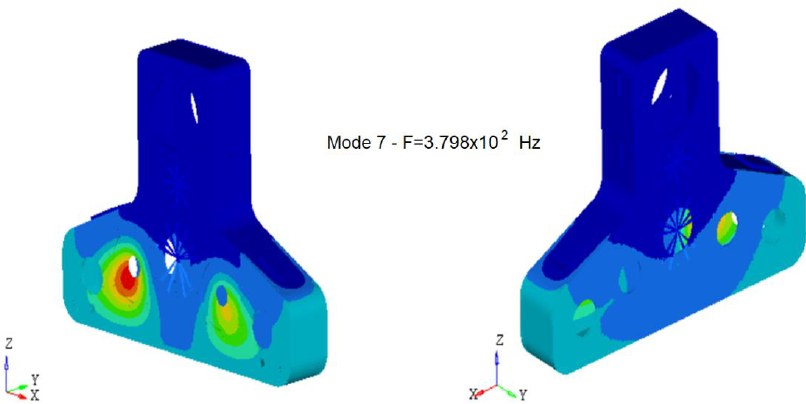
Figure 6. Eigenmode 1 (frequency — 135.51 Hz).